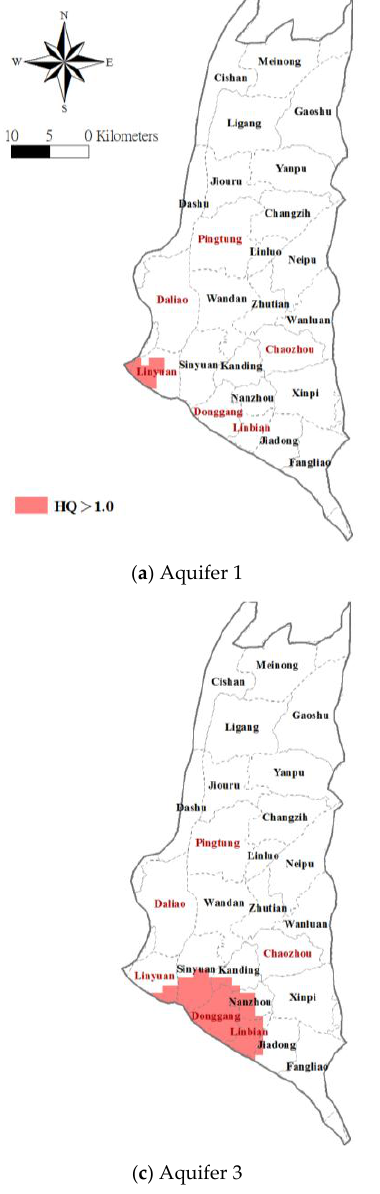
Figure 6. Spatial distribution of estimated hazard quotient (HQ) with HQ values >1 indicated in red.